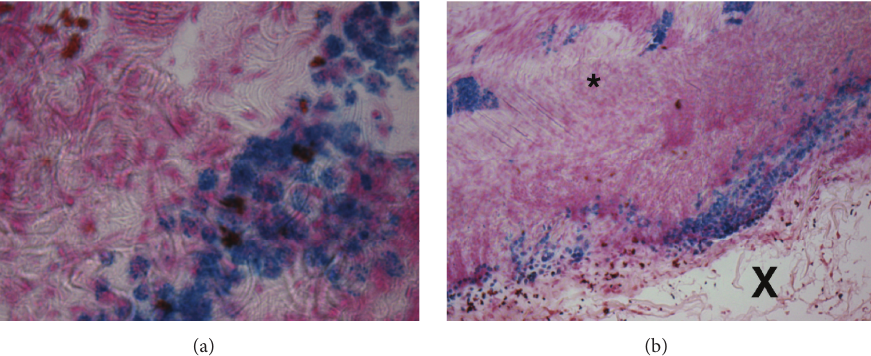
Figure 10: Histology of iron-labeled cells. Tissue sections demonstrate dense areas of Prussian Blue-positive, SPIO-treated MSCs lining the tendon lesion. Markers indicate the tendon lesion (X) and the tendon matrix ( ∗ ). Images shown are at (a) 10x and (b) 40x.